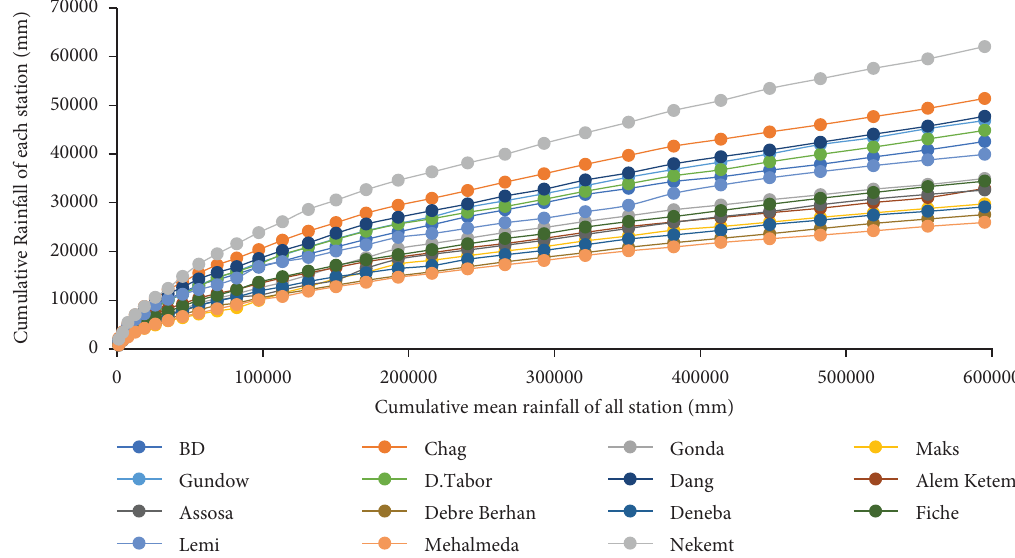
Figure 2: Consistency test of rainfall data in Abbay river basin using double mass curve.